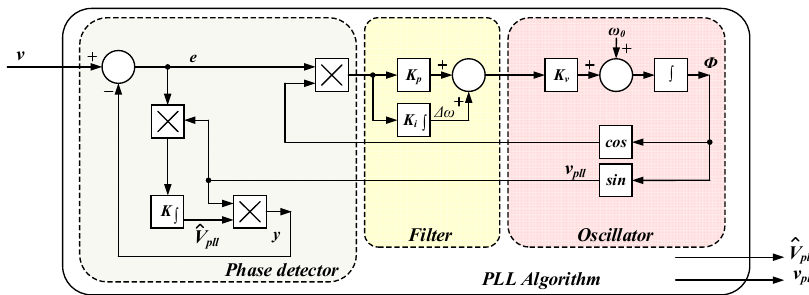
Figure 9. Block diagram of the PLL control algorithm (based on [28]).